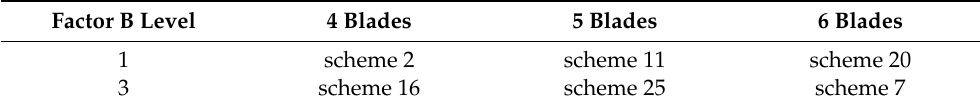
Table 10. Schemes with factor B.